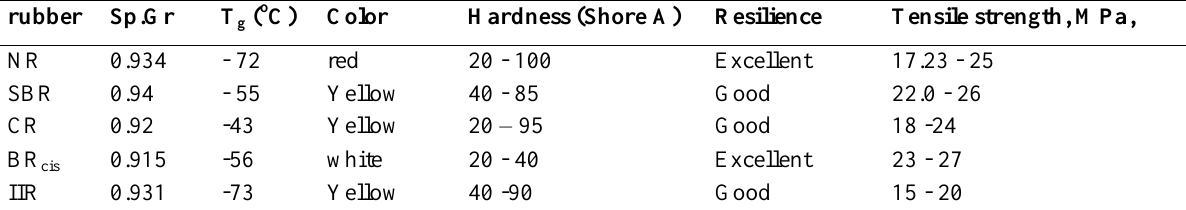
Rubbers Specification [13]. rubber